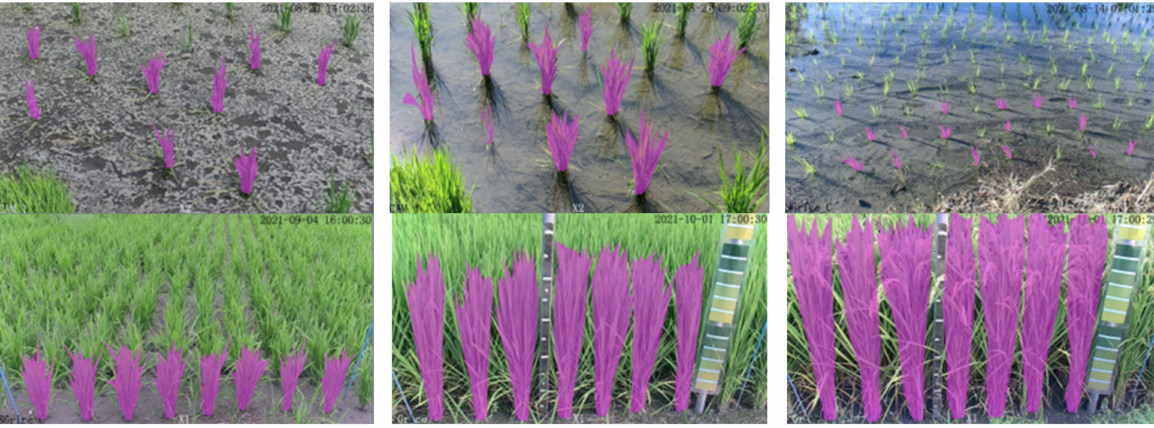
Figure 10. Demonstration of Labelled